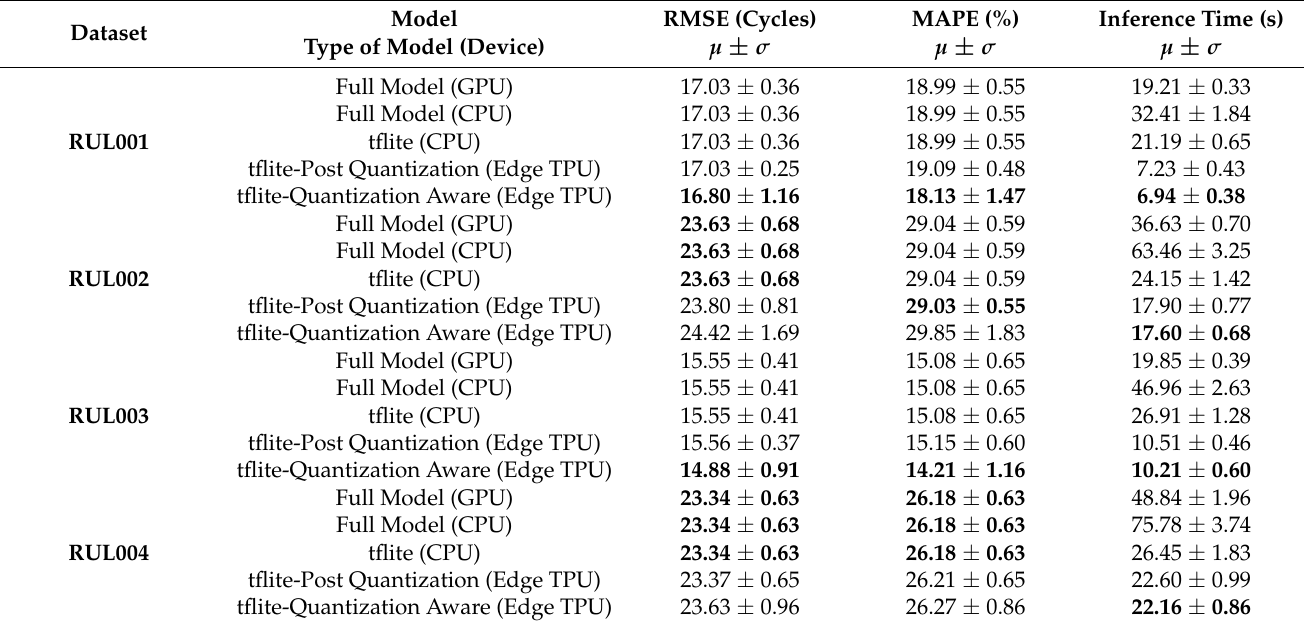
Table 1. Experimental results from different model–device combinations. The evaluation metrics were the Root Mean Squared Error (RMSE), Mean Absolute Percentage Error (MAPE), and the inference time reported as the mean ± standard deviation across 30 repetitions. The best results are in